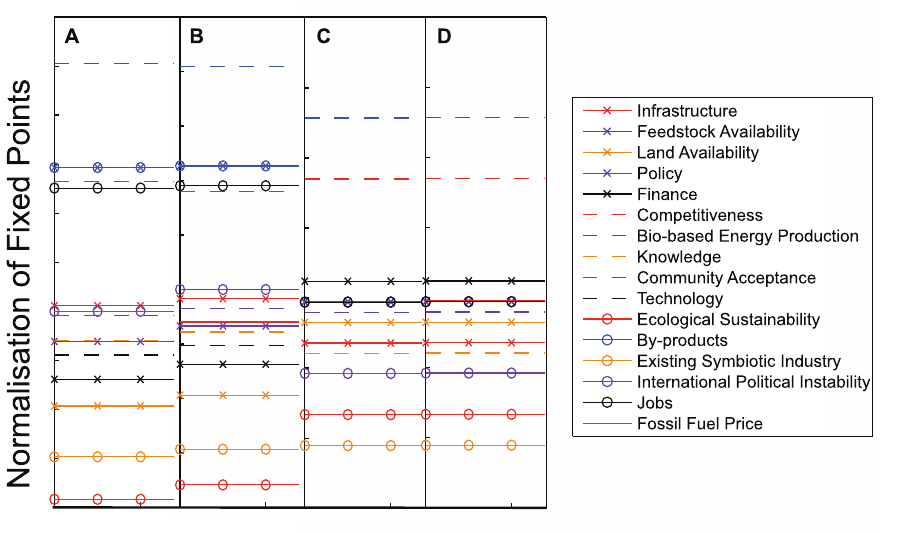
Figure 6. Results of adding in a link from international instability to fossil fuel price. Figures show ranking of factors at a stable fixed point using a linear map without (a) or with (b) the additional link, or using a sigmoidal map without (c) or with (d) the additional link.